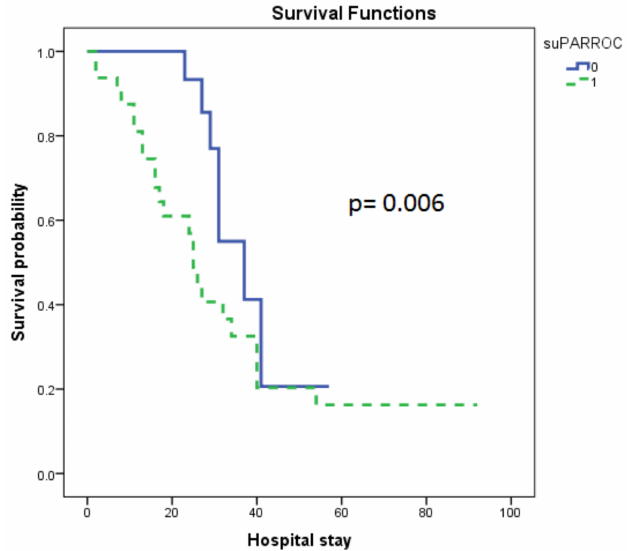
Figure 3. suPAR levels on admission and COVID-19 survival probability. suPAR levels were mea- sured on hospital admission (within 24 h). The Kaplan-Meier method was used for survival probabil- ity estimation and the log-rank test for two-group comparison. The COVID-19 group